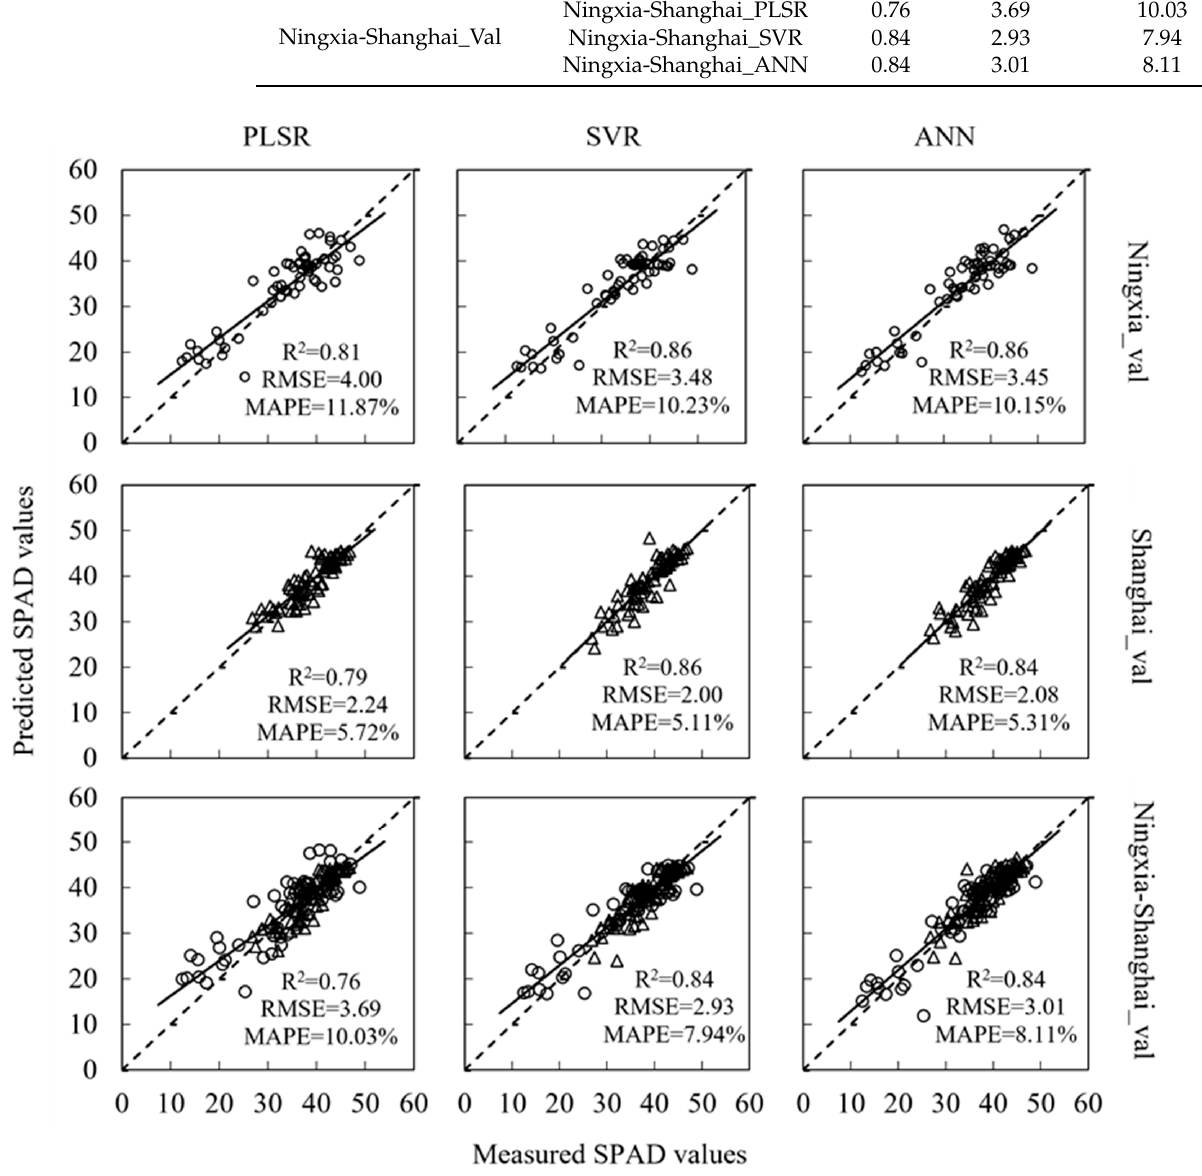
Figure 3. Measured vs. predicted LCC (SPAD values) values with different methods for the same group. ○ denotes Ningxia sample. ∆ denotes Shanghai sample.